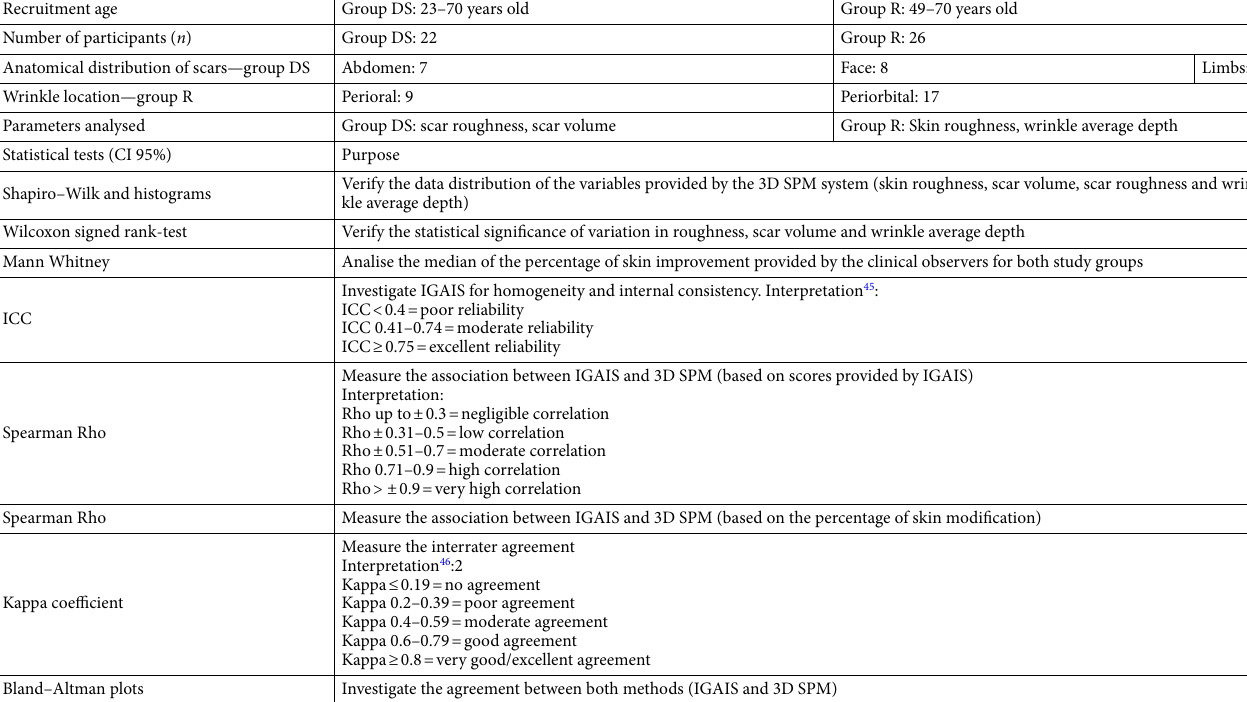
Table 1. Summary of the material and statistical tests involved in this